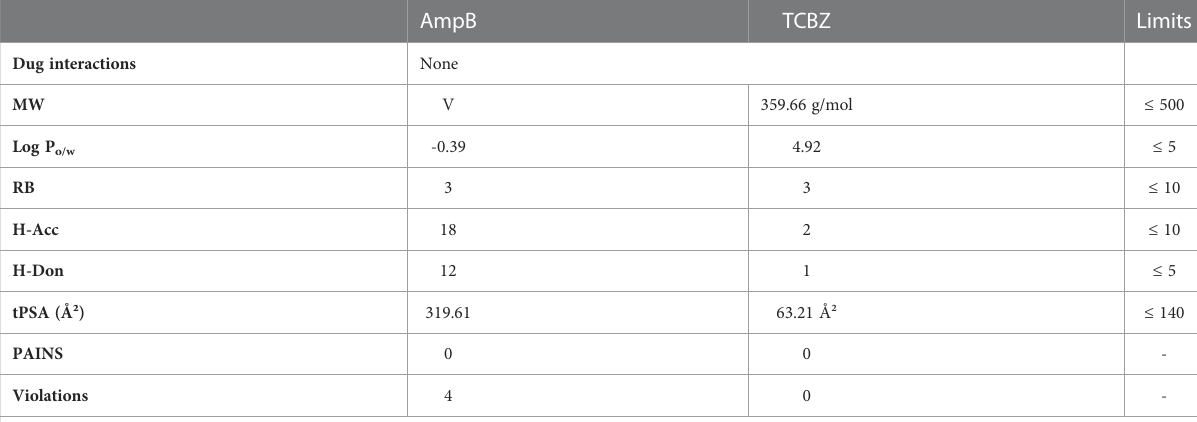
TABLE 1 Molecular properties of Amphotericin B (AmpB) and Triclabendazole (TCBZ) on Lipinski ’ s and Veber ’ s criteria, the number of pan assay interference compounds according to SwissADME web tool, and the presence of drug interactions according to